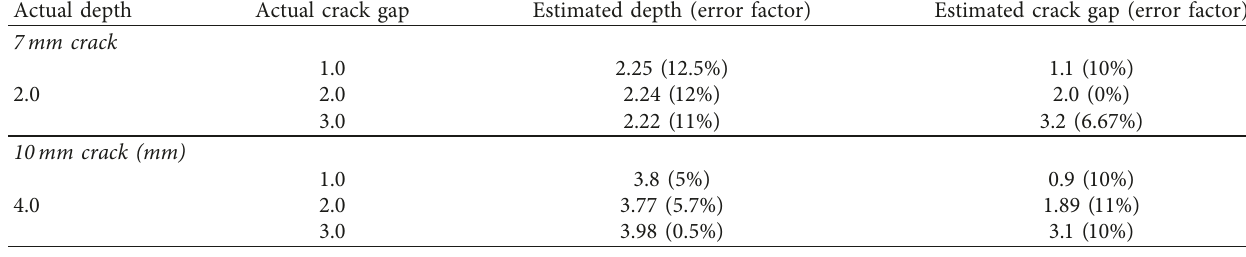
Table 4: Inspection results for V-double type crack (mm).